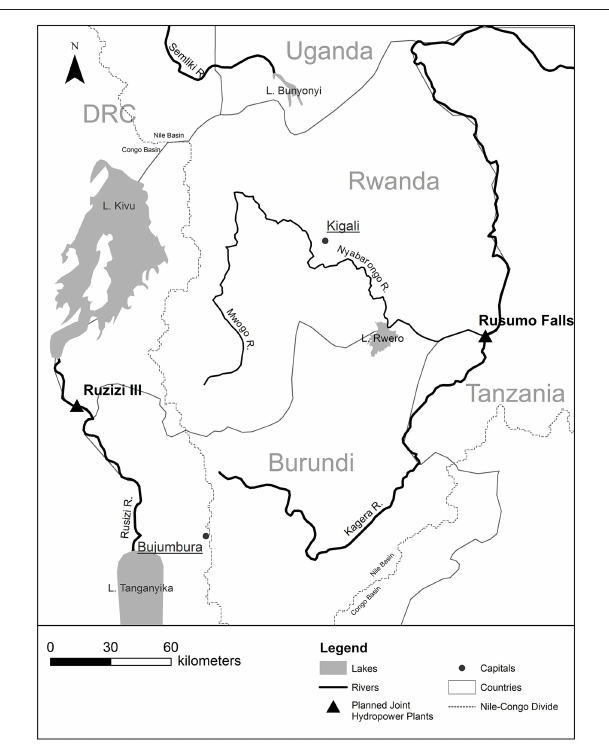
FIGURE 1 | Location of the Rusumo Falls and Ruzizi III projects, Source: Own preparation.